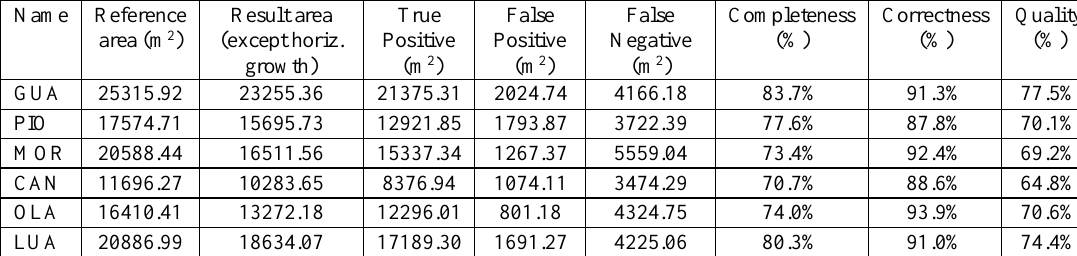
Table 4. Quality assessment per-area